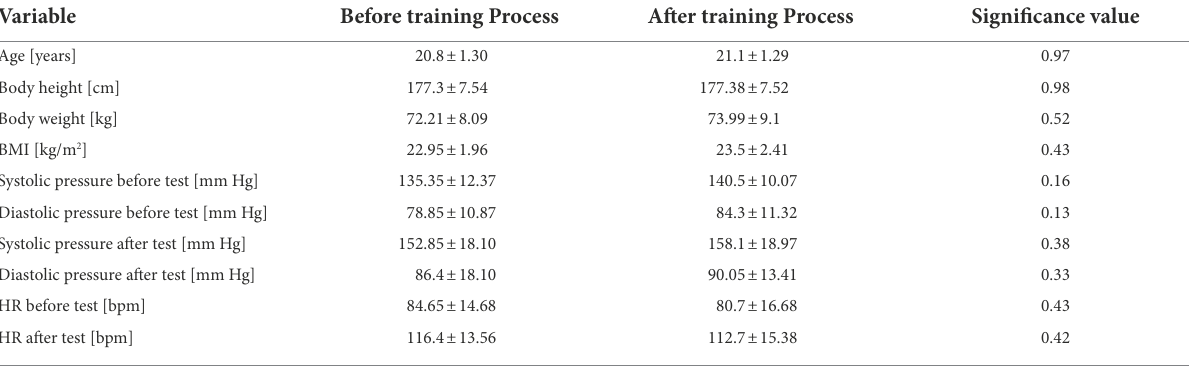
TABLE 5 Somatic data and haemodynamic parameters during the psychomotor test before and after the training process in cadet pilots. Variable